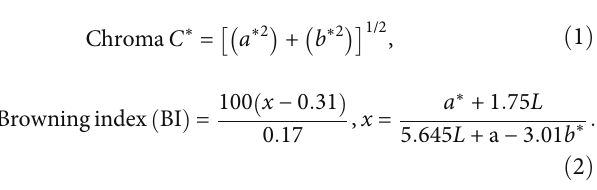
Ingredients (g) Tea bread Sugar